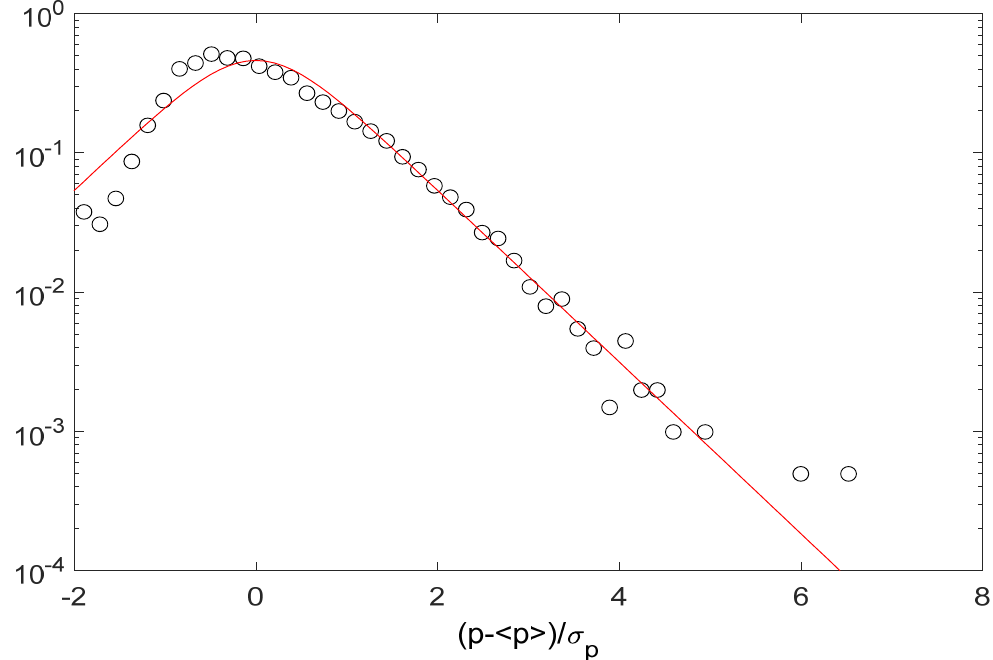
Figure 8. Same as previous plot but for the amplitude A.